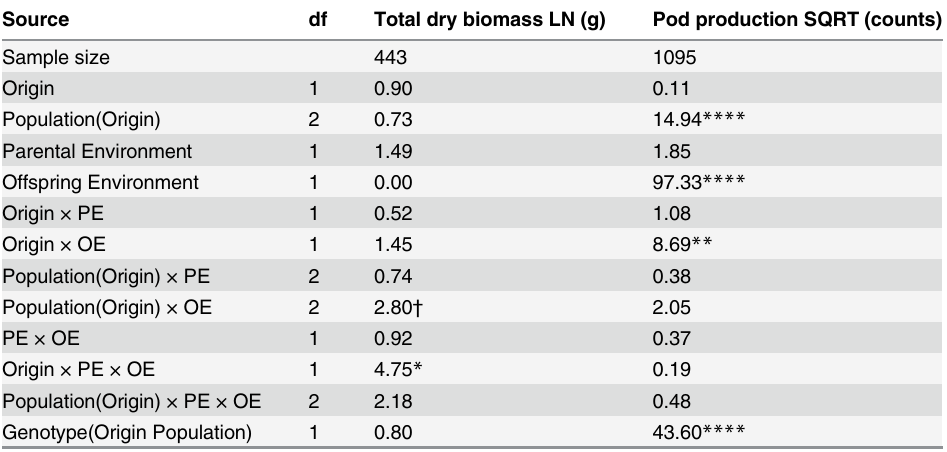
Table 1. Mixed-model analysis of variance results on the performance traits. Source df Total dry biomass LN (g)